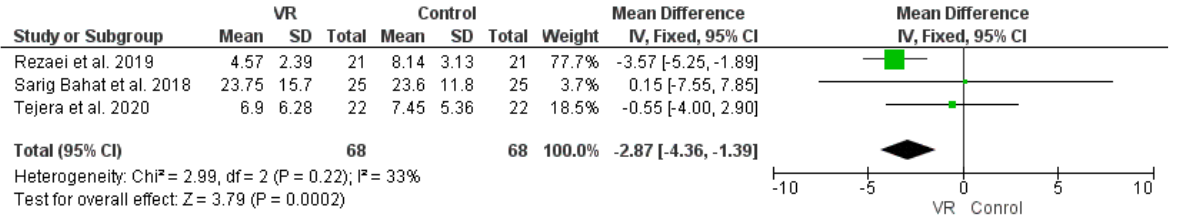
mean difference for each study, while black rhombus represents the aggregated average of the